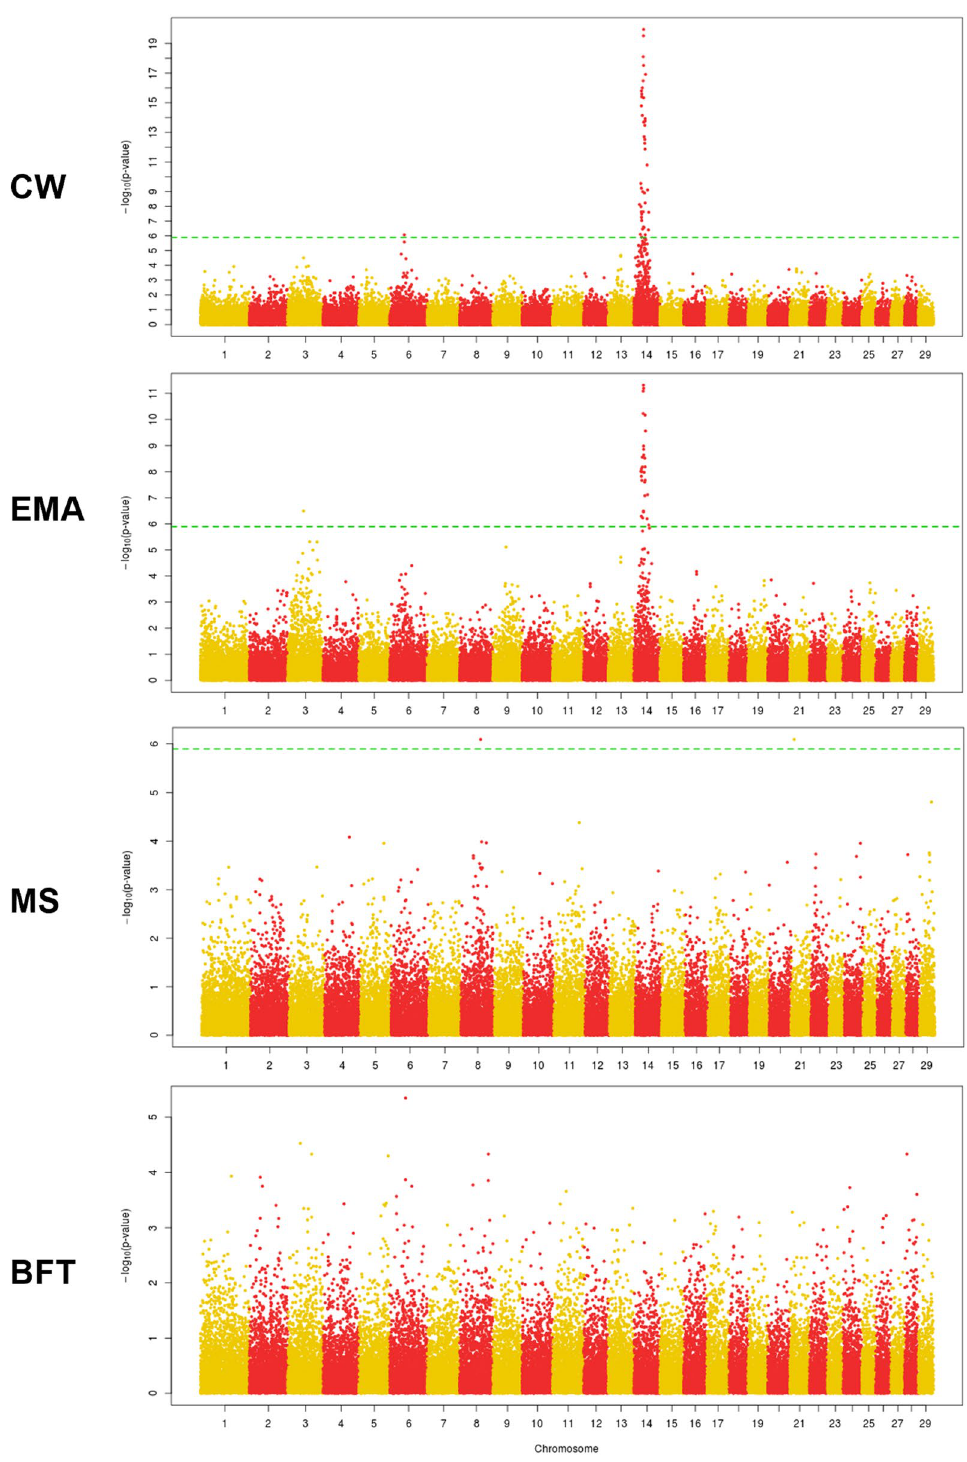
Figure 7. Genome-wide association study (GWAS) results for KPN cattle. CWT carcass weight, EMA eye muscle area, BFT back fat thickness, MS marbling